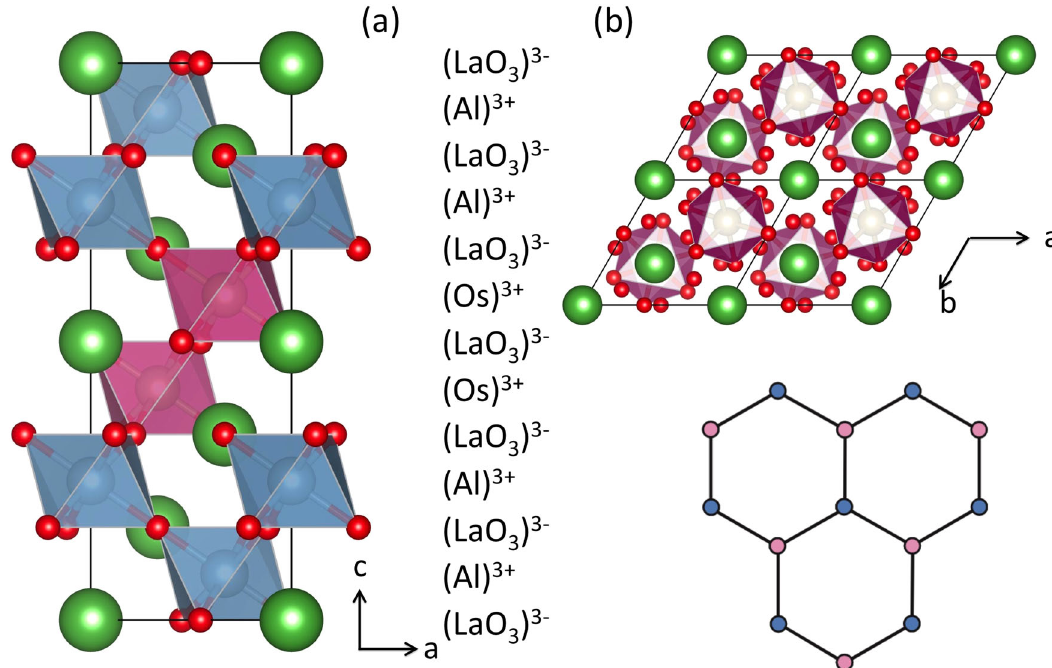
Fig. 1 Geometry of this honeycomb lattice system. a Side view of one cell of the ( LAO ) 4 /( LXO ) 2 (111) superlattice. b Top view of the 2LXO bilayer forming a buckled honeycomb lattice (lower right) from bilayer of Os cations. Blue sites lie in a plane above the plane containing the pink sites